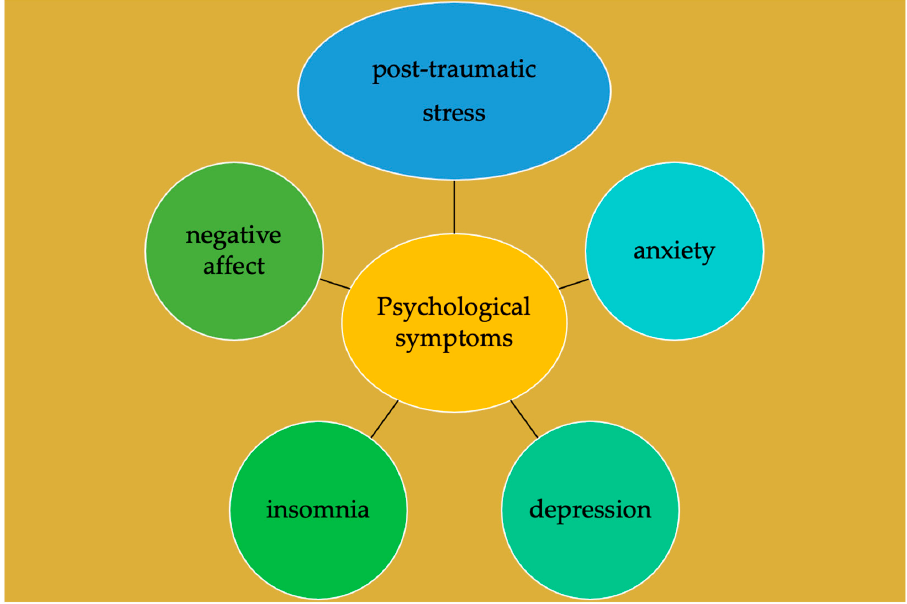
Figure 2. Schematic representation of the main mental disorders in pregnant women during the COVID-19 pandemic induced by causes reported in Figure